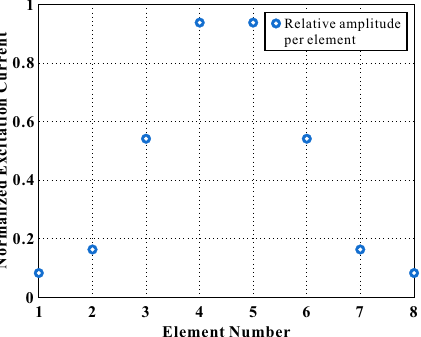
Figure 13. Amplitude tapering curves applied to actually validation